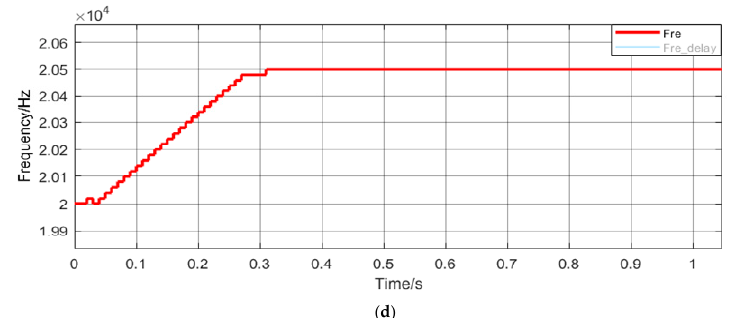
Figure 11. Output current and switching frequency regulation of the DCX#2 and DCX#3. ( a ) Output current changing with the switching frequency of DCX#2; ( b ) Switching frequency regulation of DCX#2; ( c ) Output current changing with the switching frequency of DCX#3 and ( d ) Switching frequency regulation of DCX#3.